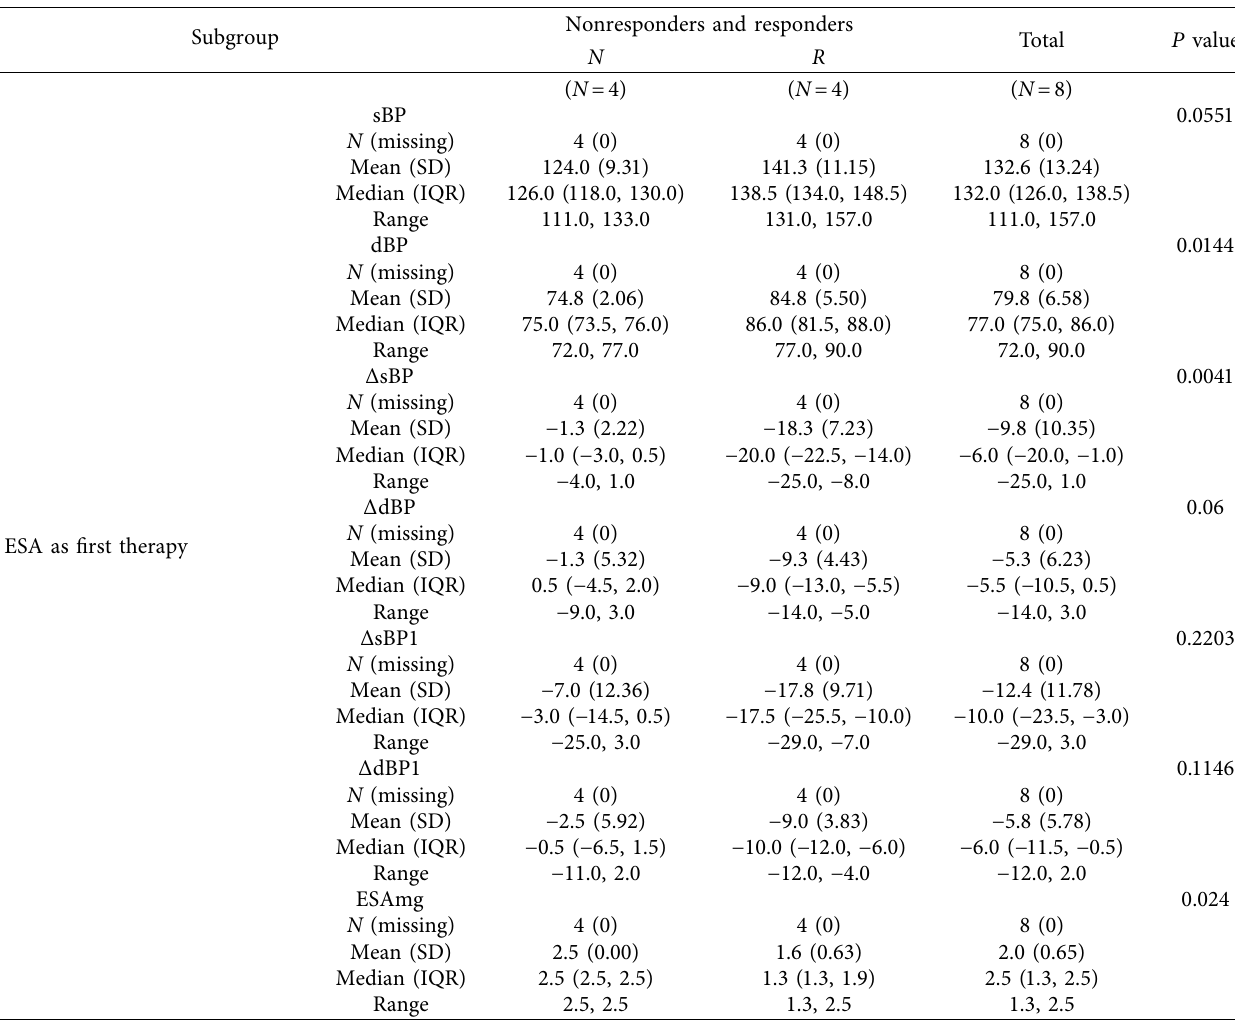
Table 5: Subgroup analysis; ESA as frst MRA or switched from another